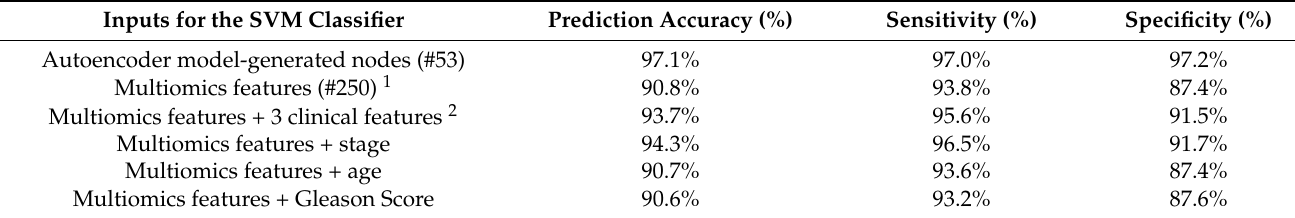
Table 3. Fivefold cross-validation of the prediction accuracy of support vector machine (SVM) classifiers corresponding to different combinations of omics and clinical